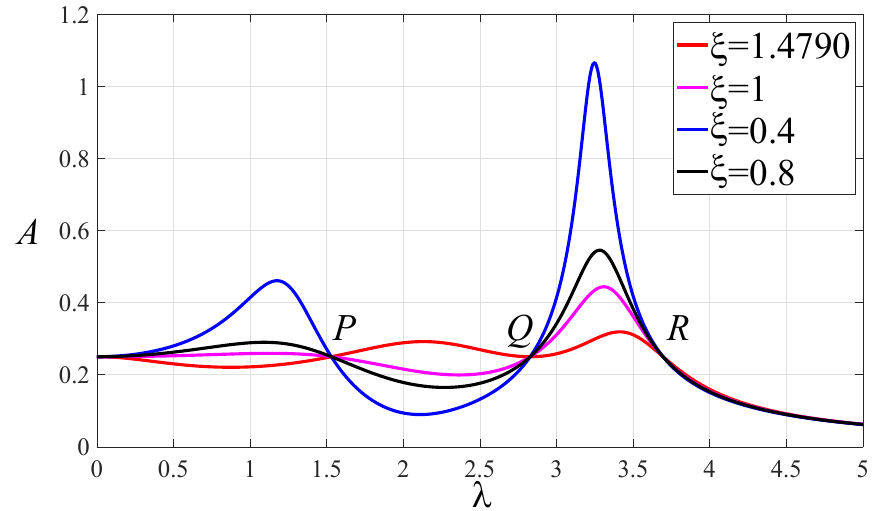
Figure 3. The normalized amplitude–frequency curves of system with µ = 0.1, β = 1.5, ν = 2.3904, α 1 = 3.5, α 2 = 0.75, L =